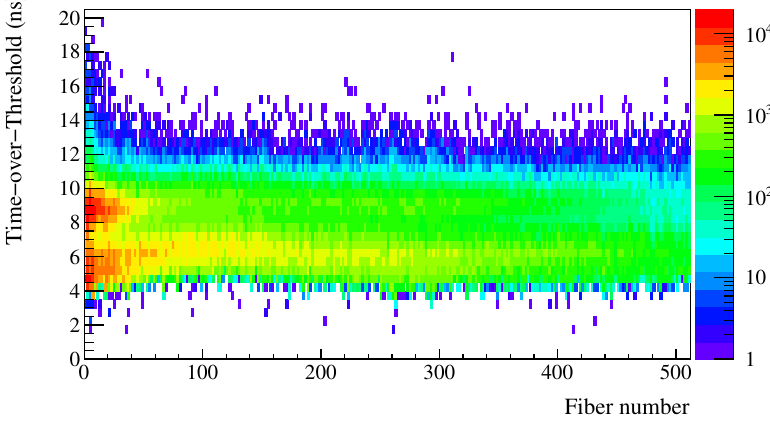
Figure 4. Fiber number of one detector behind GLAD vs. deposited energy as Time-over-Threshold. 12 C deposits more energy than 4 He, and they can be easily